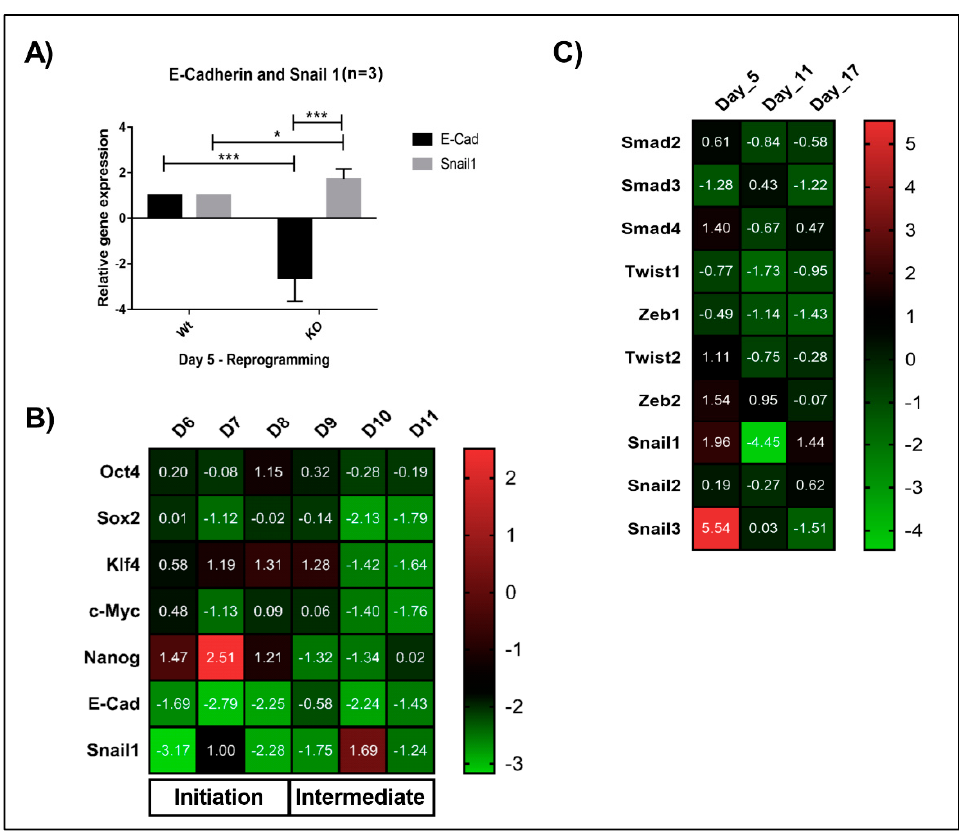
Figure 3. Lack of Math6 disrupts mesenchymal-to-epithelial transition (MET) and somatic cell reprogramming. ( A ) Relative gene expression of the epithelial marker E-cadherin and mesenchymal marker Snail1 on day 5 of WT and KO reprogramming cells. The data presented is normalized to GAPDH . This is applicable to all the gene expression data shown in this figure. ( B ) Expression of Yamanaka’s factors ( OSKM ), Nanog , MET markers ( Snail1 and E-cadherin ) during the reprogramming from day 6-11 ( n = 3). ( C ) Expression of pro-mesenchymal genes during different phases of KO reprogramming cells on Day 5, 11 and 17 ( n = 3). Statistical significance levels were shown as * p ≤ 0.05 and *** p ≤ 0.001.